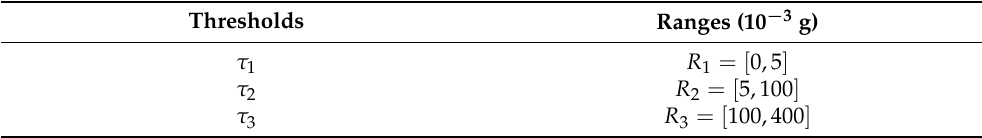
Table 2. Thresholds and their corresponding identified ranges for